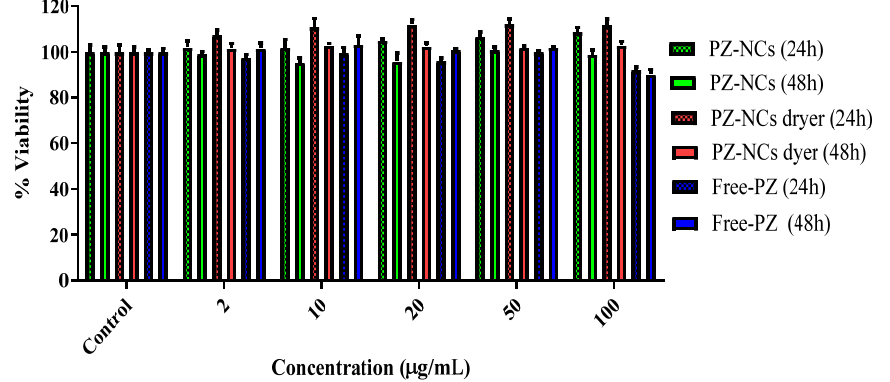
Figure 4. Evaluation of in vitro toxicity using the resazurin assay (alamarBlue™ assay). Variation of cell viability (%) with PZ concentration ( μ g/mL). Data are expressed as the mean ± SD ( n = 6).